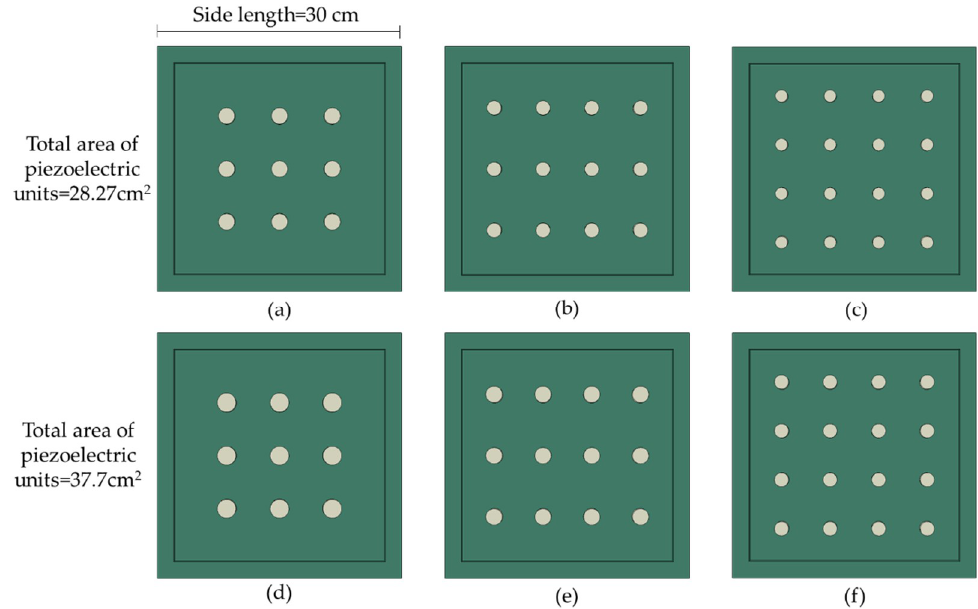
Figure 7. Piezoelectric unit distributions in PEH by: ( a ) 3 × 3 with diameter = 2 cm; ( b ) 3 × 4 with diameter = 1.73 cm; ( c ) 4 × 4 with diameter = 1.5 cm; ( d ) 3 × 3 with diameter = 2.3 cm; ( e ) 3 × 4 with diameter = 2 cm; ( f ) 4 × 4 with diameter = 1.73 cm.